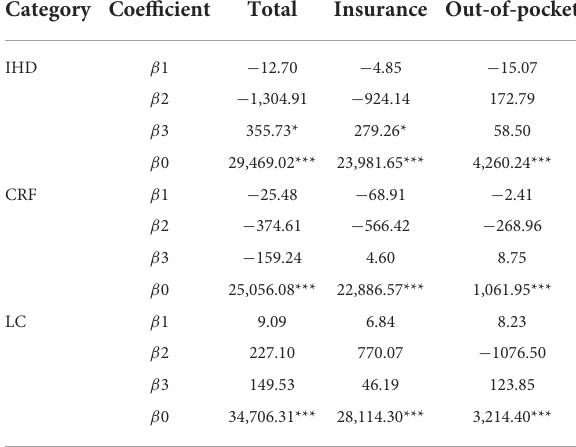
TABLE 2 Impacts on hospitalization expenses (ITS